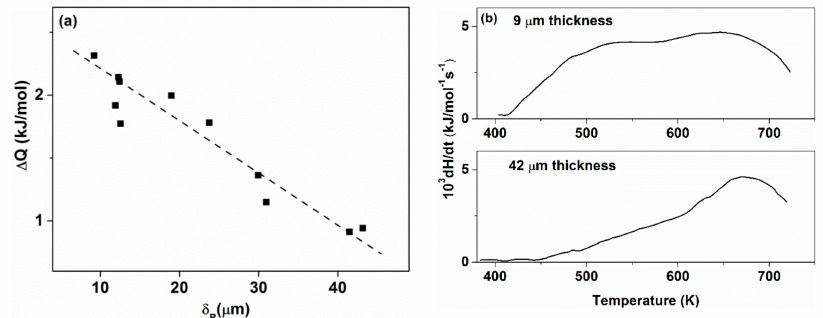
Figure 12. ( a ). Relaxation energy as a function of ribbon thickness and ( b ) typical heat release curves for 9 and 42 µ m thick ribbons. Adopted from [81], with permission from Elsevier,